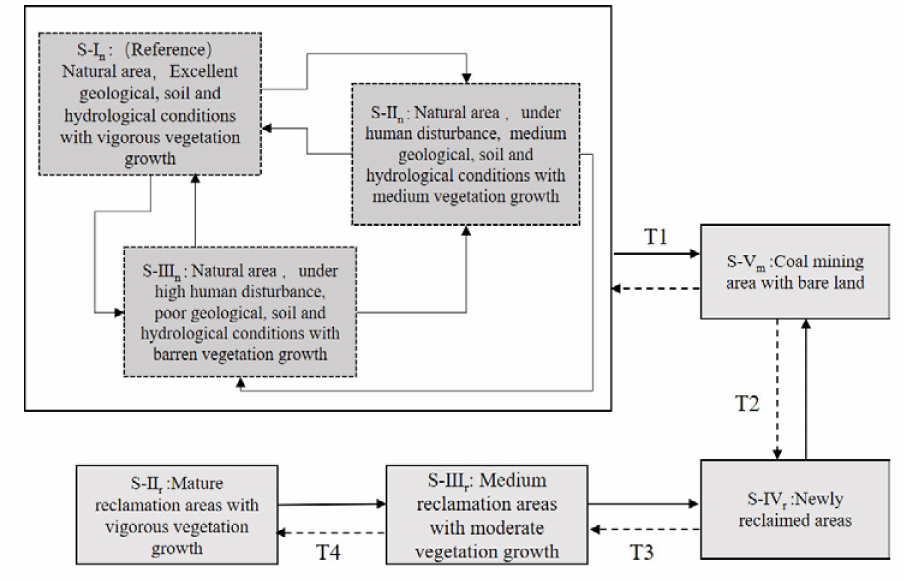
Figure 4. Conceptual state and transition model for Jungar Banner coal mining ecosystems based on the random points method. The gray boxes represent states (Roman numerals), the subscript n represents natural areas, the subscript r represents reclaimed areas, and the subscript m represents mining areas. The dotted line boxes are phases within the same state and the black polyline arrows represent reversible pathways between phases. The black solid straight arrows represent negative transitions between states (negative disturbance, e.g., mining activities or drought), and the black dashed straight arrows represent positive transitions (vegetation restoration) (labeled in letter T with Arabic numerals, which refer to state transition